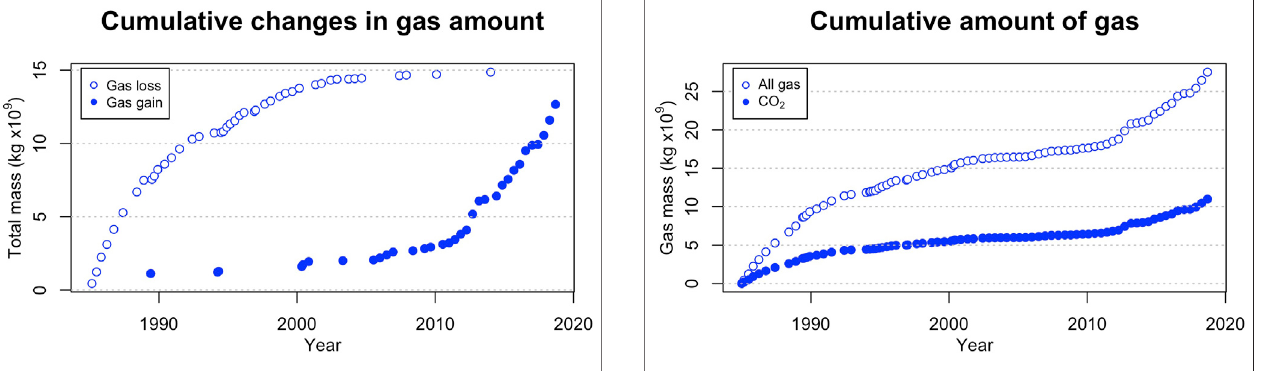
FIGURE 9 | Mass of gas leaving the hydrothermal reservoir since 1985 (open symbols) compared to the total amount of gas entering the reservoir (solid symbols) during the same time interval.